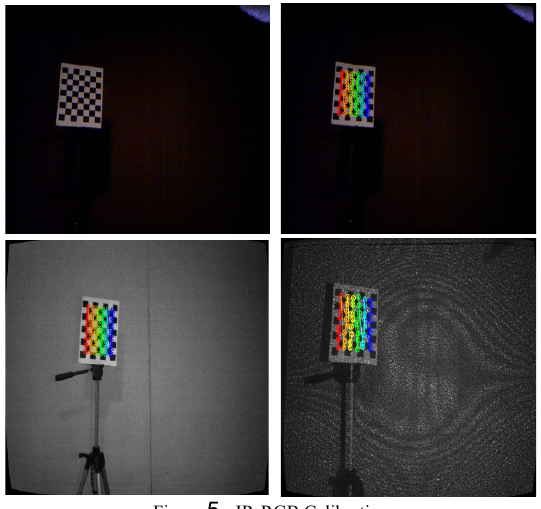
Figure 5 - IR-RGB